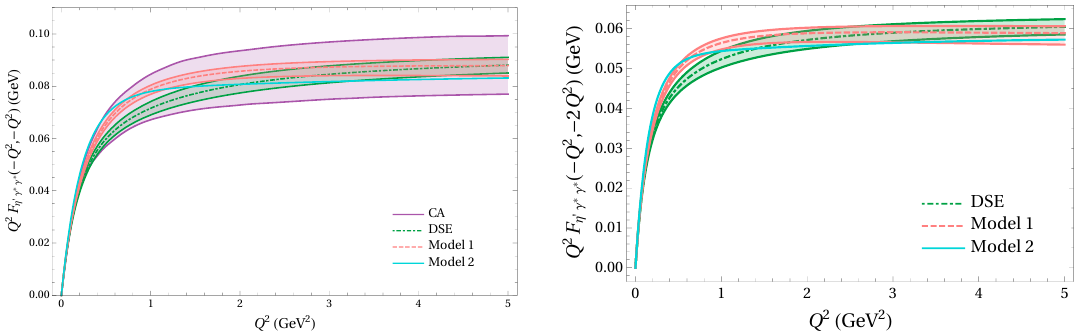
= Q 2 = Q 2 (left) and in the region 1 2